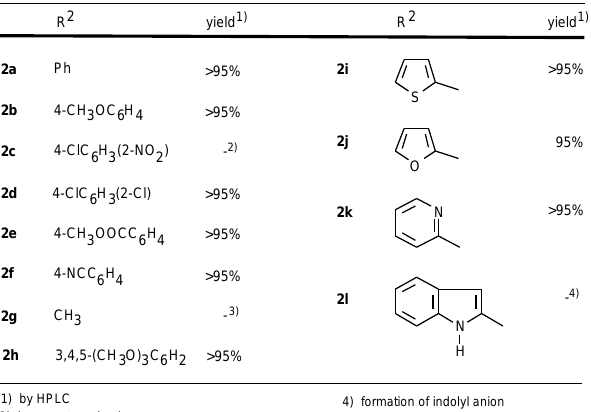
Table 2. Claisen condensation to b -diketone 2a-l (R 1 = 4-Ph).